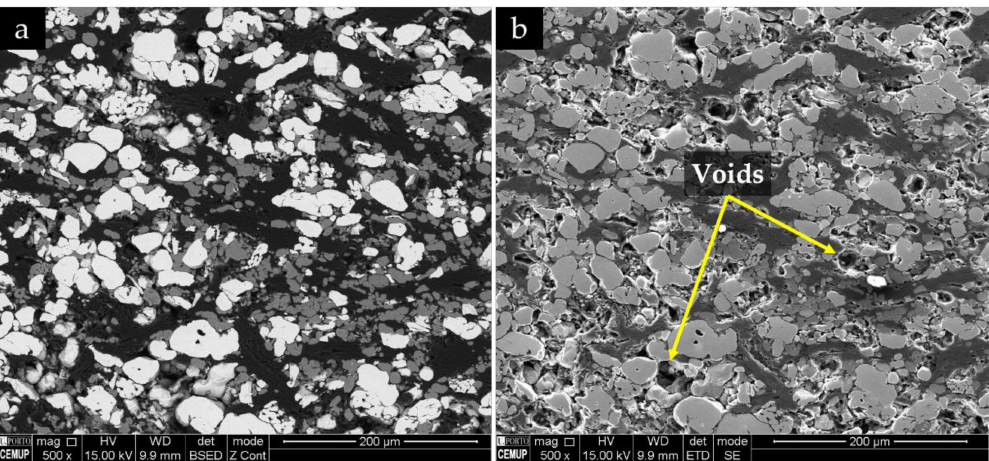
Figure 6. SEM images of the green powder compacts, using ( a ) BSE mode and ( b ) secondary electron (SE)